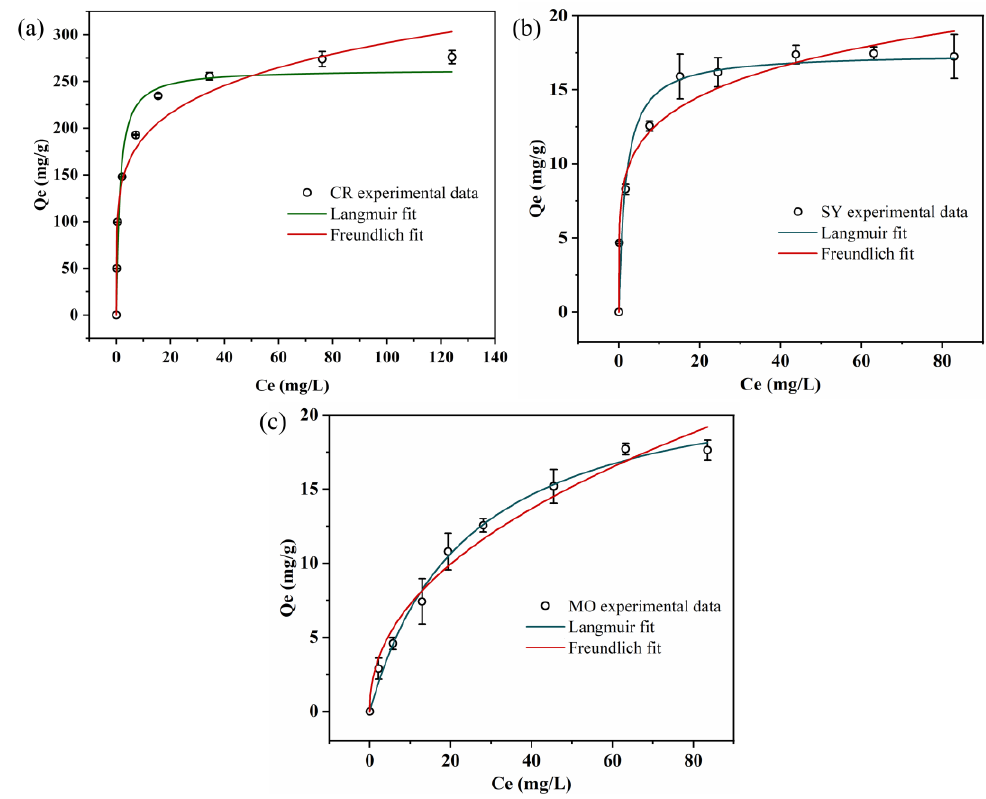
Figure 12. Different initial concentration of dyes ( a ) CR, ( b ) SY and ( c ) MO sorption onto PDA/PEI- TPU NFMs. Table 3. Isotherm parameters for adsorption of three dyes onto the PDA/PEI-TPU NFMs.